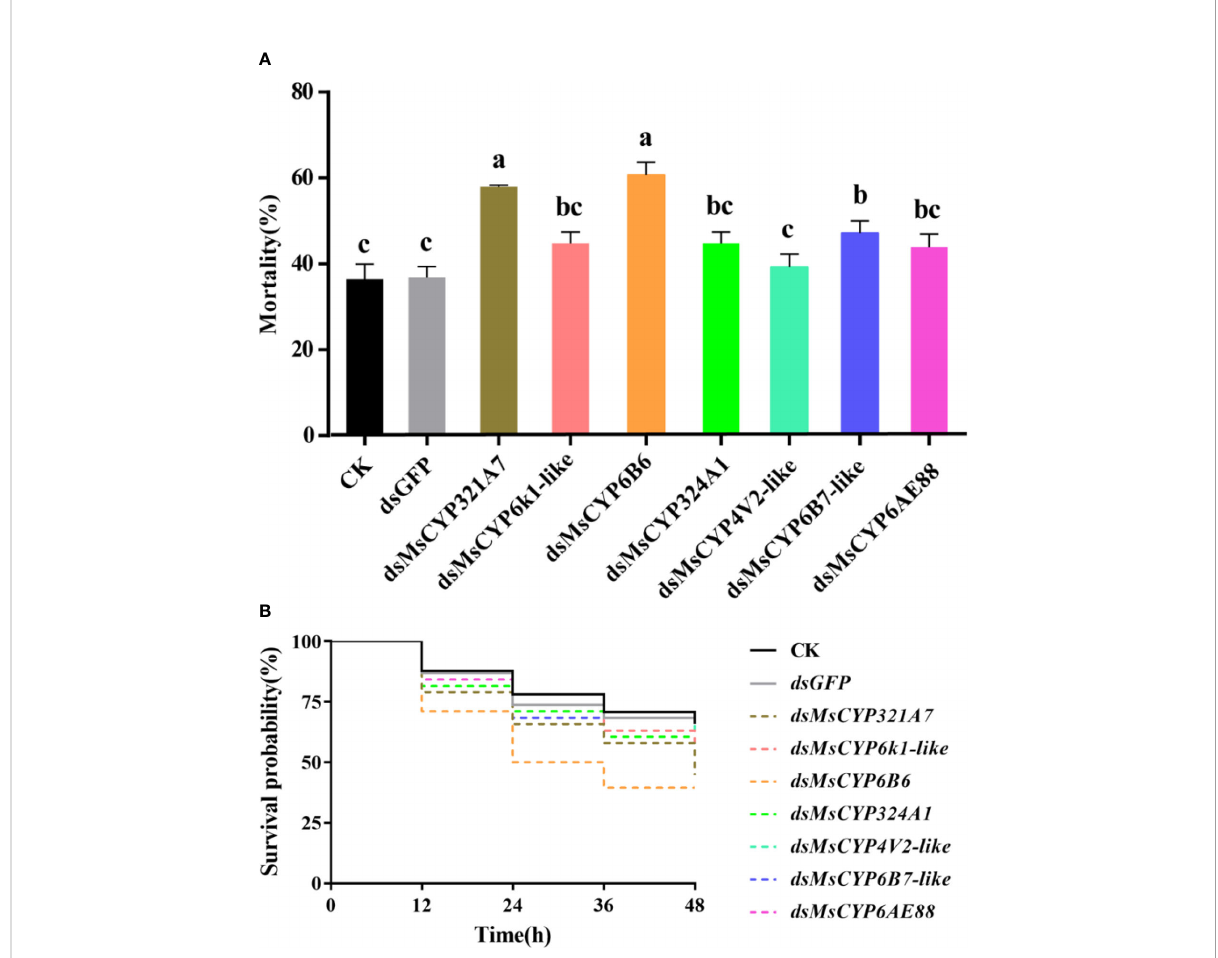
FIGURE 7 The larval mortality and survival rates for M. separata larvae after dsRNA treatment. (A) Larvae were continuously fed dsRNA for 3 days, and mortality was evaluated for 2 days; (B) The survival rates of larvae scored for 2 days after dsMsCYP450 gene treatment for 3 days. Different lowercase letters (a, b and c) above the bars indicate signi fi cant differences (p < 0.05) based on one-way ANOVA followed by Tukey ’ s HSD test for multiple comparisons. Means ± SE from three replicates are